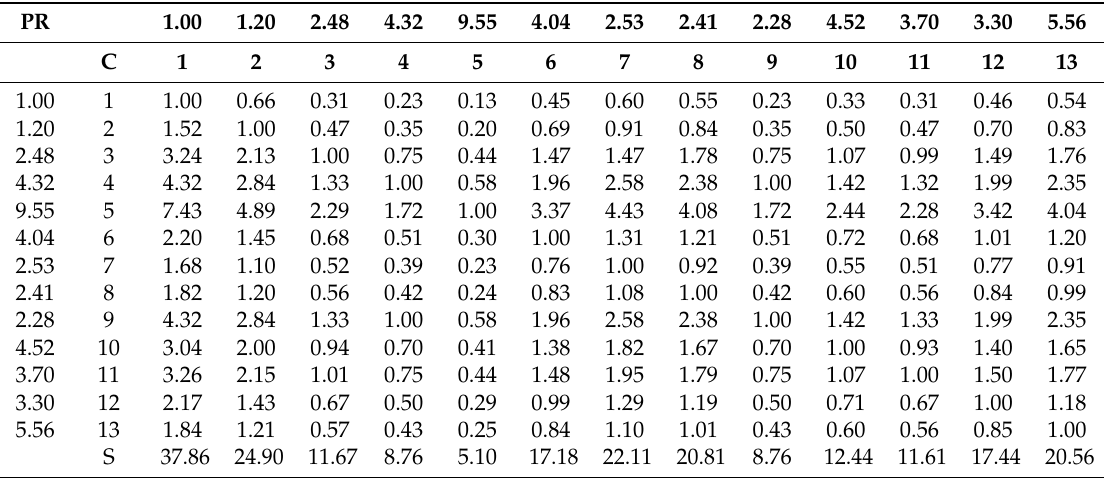
Table 3. Pairwise wise comparison predisposing factors of landslide